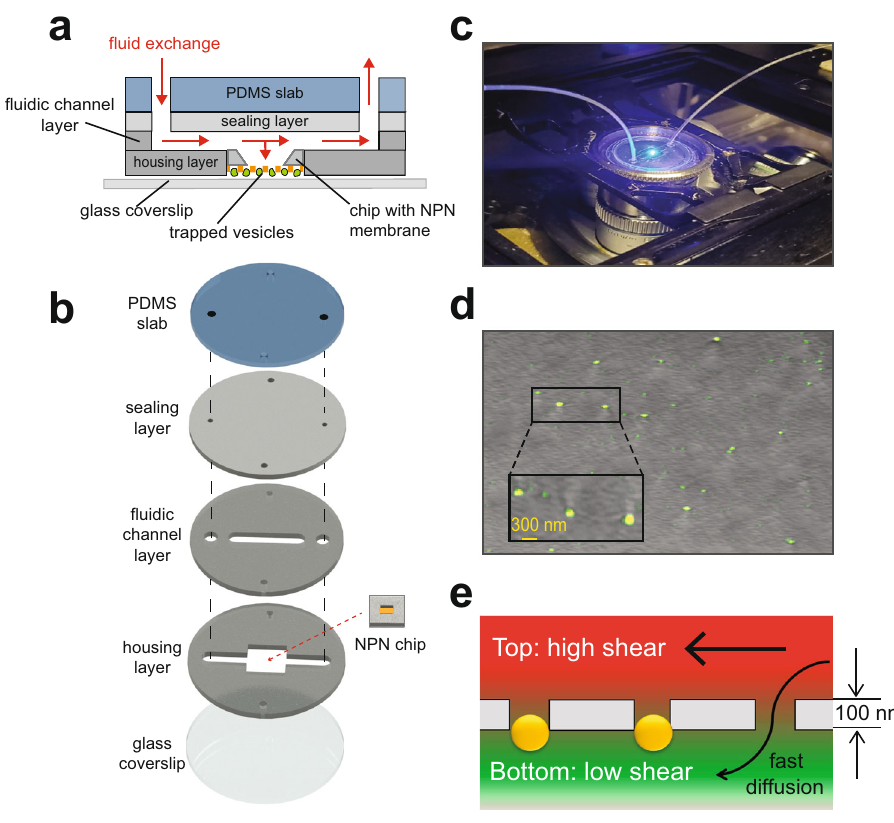
Fig. 2 NPN membrane-based platform for investigation of EV properties in real time. a Schematic cross-sectional diagram of the micro fl uidic device used to study functional responses of individual, membrane-stabilized EVs in response to changes in ionic composition of external solution. b Stack of PDMS layers comprising the device, including the housing layer patterned for insertion of the NPN chip. c Photograph of the device assembled on the stage of laser scanning confocal microscope. Inlet and outlet tubing allowed for the fl ow of solutions over the NPN membrane-immobilized vesicles, at a rate of 5 – 10 µ l/min, maintained by a pressure-driven micro fl uidic fl ow system (ElveFlow ® ). d Image of fl uorescent beads (100 nm in diameter), trapped and retained on the NPN membrane under conditions of tangential fl ow (scale bar 300 nm). e Schematic depiction of how the ultrathin (100 nm thick) nanoporous NPN membrane (gray) separates perfusion fl ows: top compartment with high shear force provides fast solution exchange (red) which diffuses rapidly through nanopores to the bottom compartment where trapped vesicles (yellow) are exposed to low shear force intensities with a mean FWHM of 274 nm (Fig. 3b, (right panel, gray box). When the identical particles were imaged using sti- mulated emission depletion (STED) super-resolution imaging (Fig. 3b, STED) microscopy and analyzed, a Gaussian distribution of intensities resulted in a mean FWHM of 182 nm. STED ima- ging combined with the Leica LIGHTNING image deconvolution techniques (Fig. 3b, STED + Lng) yielded a Gaussian FWHW mean of 153 nm, which corresponds to the highest level of resolution obtainable with our Leica SP8-STED light microscopy (see below). The Gaussian distribution for each of the three techniques remained a single distribution suggesting that the vesicle intensities were not the result of integral multiples of aggregated particles or fusion of multiple vesicles. Measurements